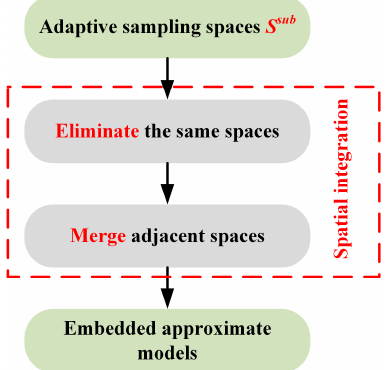
Figure 5. Flowchart of embedded approximate model.